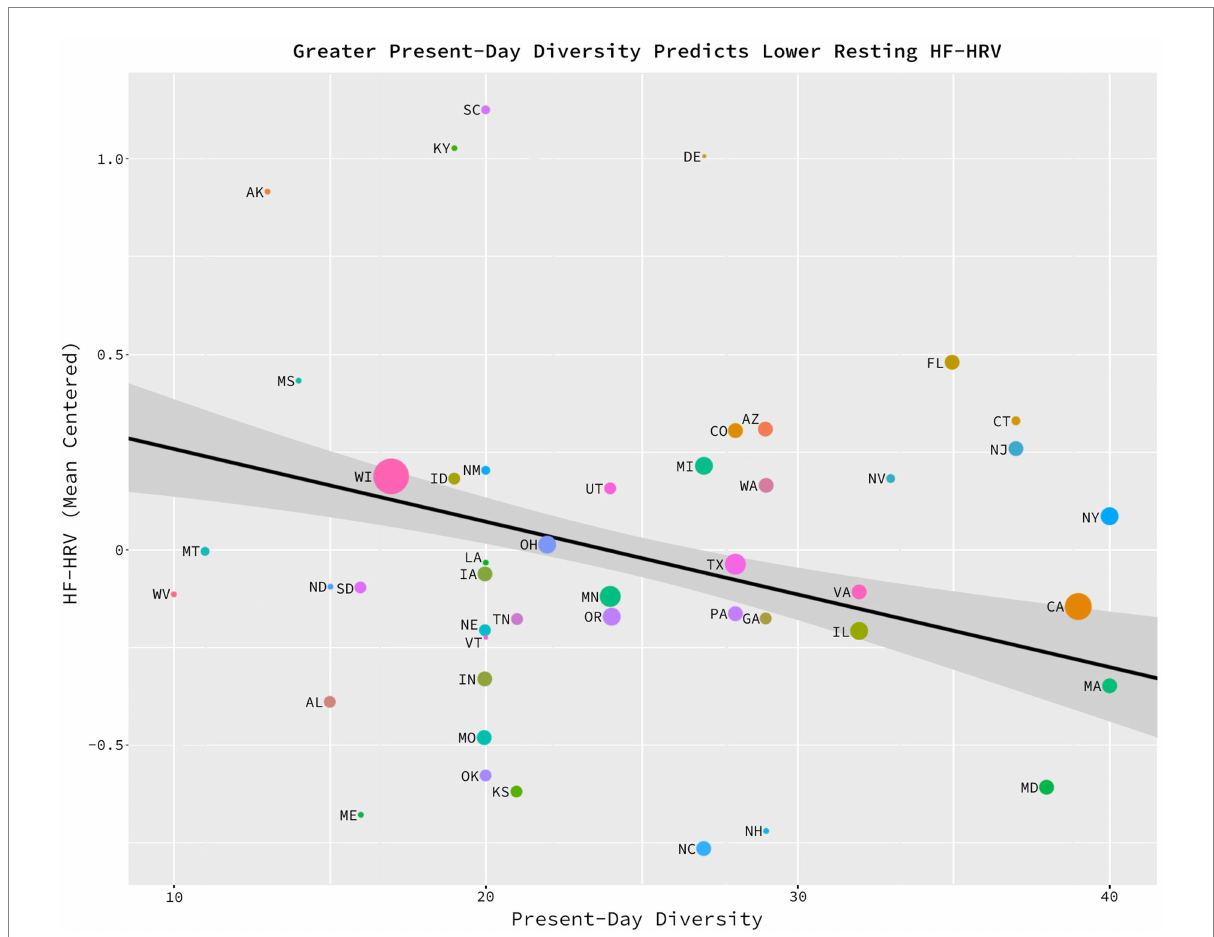
FIGURE 3 Greater present-day diversity related to lower HF-HRV. Significant negative relationship between present-day diversity and the average, baseline HF-HRV of the states’ citizens, b = − 0.018, sd_b = − 0.277, t (42) = − 2.299, p = 0.0265, η p2 = 0.11, CILO = − 0.034, CIHI = − 0.002. On the x axis, the average number of foreign countries which have contributed to at least 0.5% of a state’s population since 2010. On the y axis, a mean-centered average of baseline, HF-HRV residualized on health, age, and sex. This figure is generated from a data set consisting of 46 data points. Each data point represents one of the U.S. states (excluding Alaska, Hawaii, Rhode Island, and Wyoming). The size of each data point represents the number of observations per state from which the HF-HRV scores were